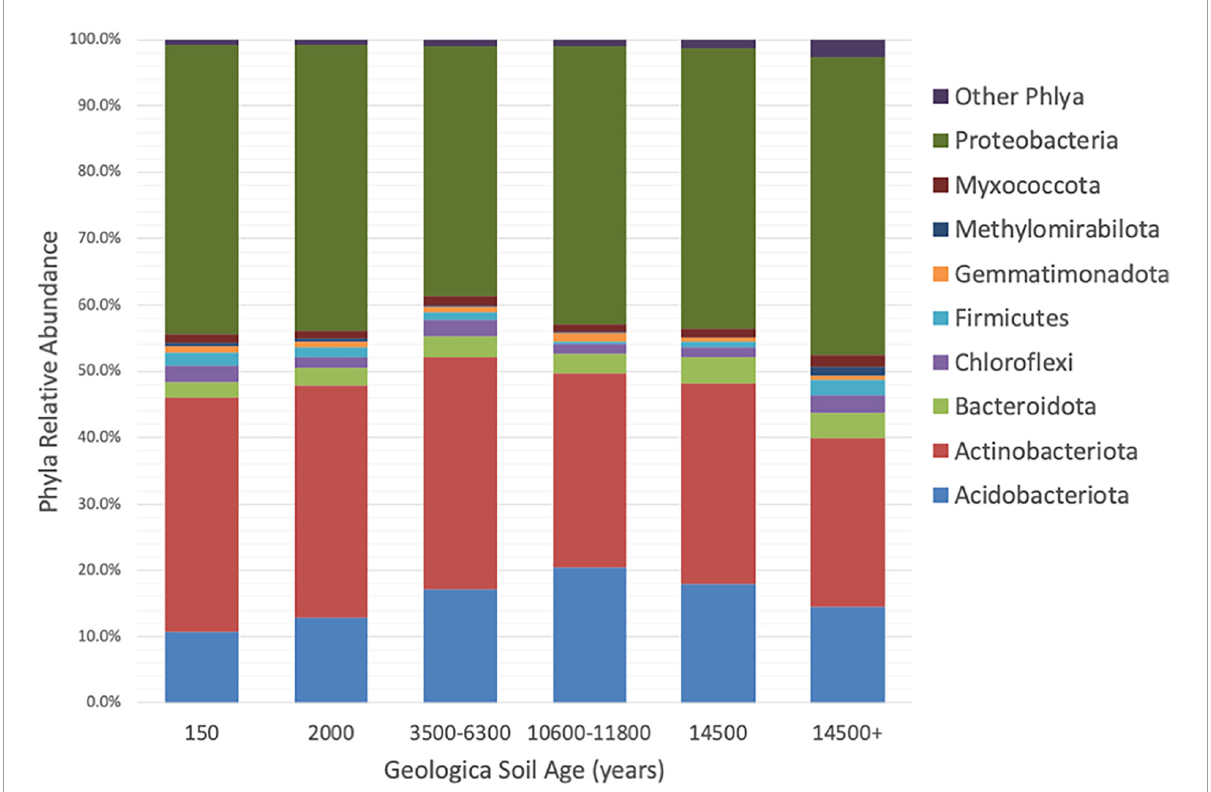
FIGURE2 Comparison of relative abundances of phyla in Asiatic bittersweet rhizosphere soils collected from soils of increasing geologic ages (ybp). Only phyla with relative abundance > 1% in at least one soil age is included. Other phyla are represented by Bdellovibrionota, Cyanobacteria, Dependentiae, Desulfobacterota, Elusimicrobiota, Entotheonellaeota, Latescibacterota, MBNT15, Myxococcota, NB1-j, Nitrospirota, Patescibacteria, Planctomycetota, RCP2-54, SAR324_clade (Marine_group_B), Verrucomicrobiota, and WPS-2. Samples were collected at Indiana Dunes National Park in